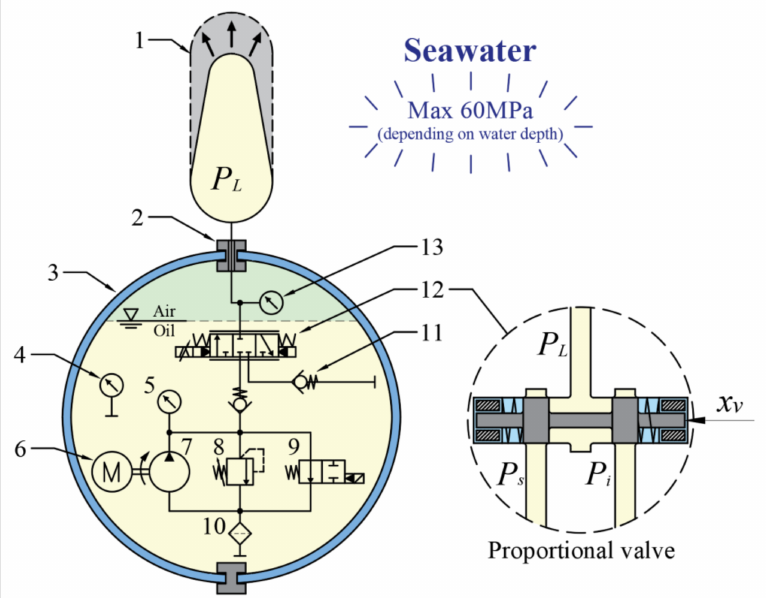
Figure 2. Hydraulic schematic diagram of the oil bladder type VBS used in AUV: (1) Oil bladder, (2) Titanium sealing ring, (3) Glass pressure-tight half-shell, (4) Pressure sensor for internal oil, (5) Pressure sensor for pump, (6) BLDC motor, (7) High pressure radial piston pump, (8) Relief valve, (9) Electromagnetic switching valve, (10) Filter, (11) Non-return valve, (12) Electro-hydraulic proportional reversing valve, and (13) Pressure sensor for oil